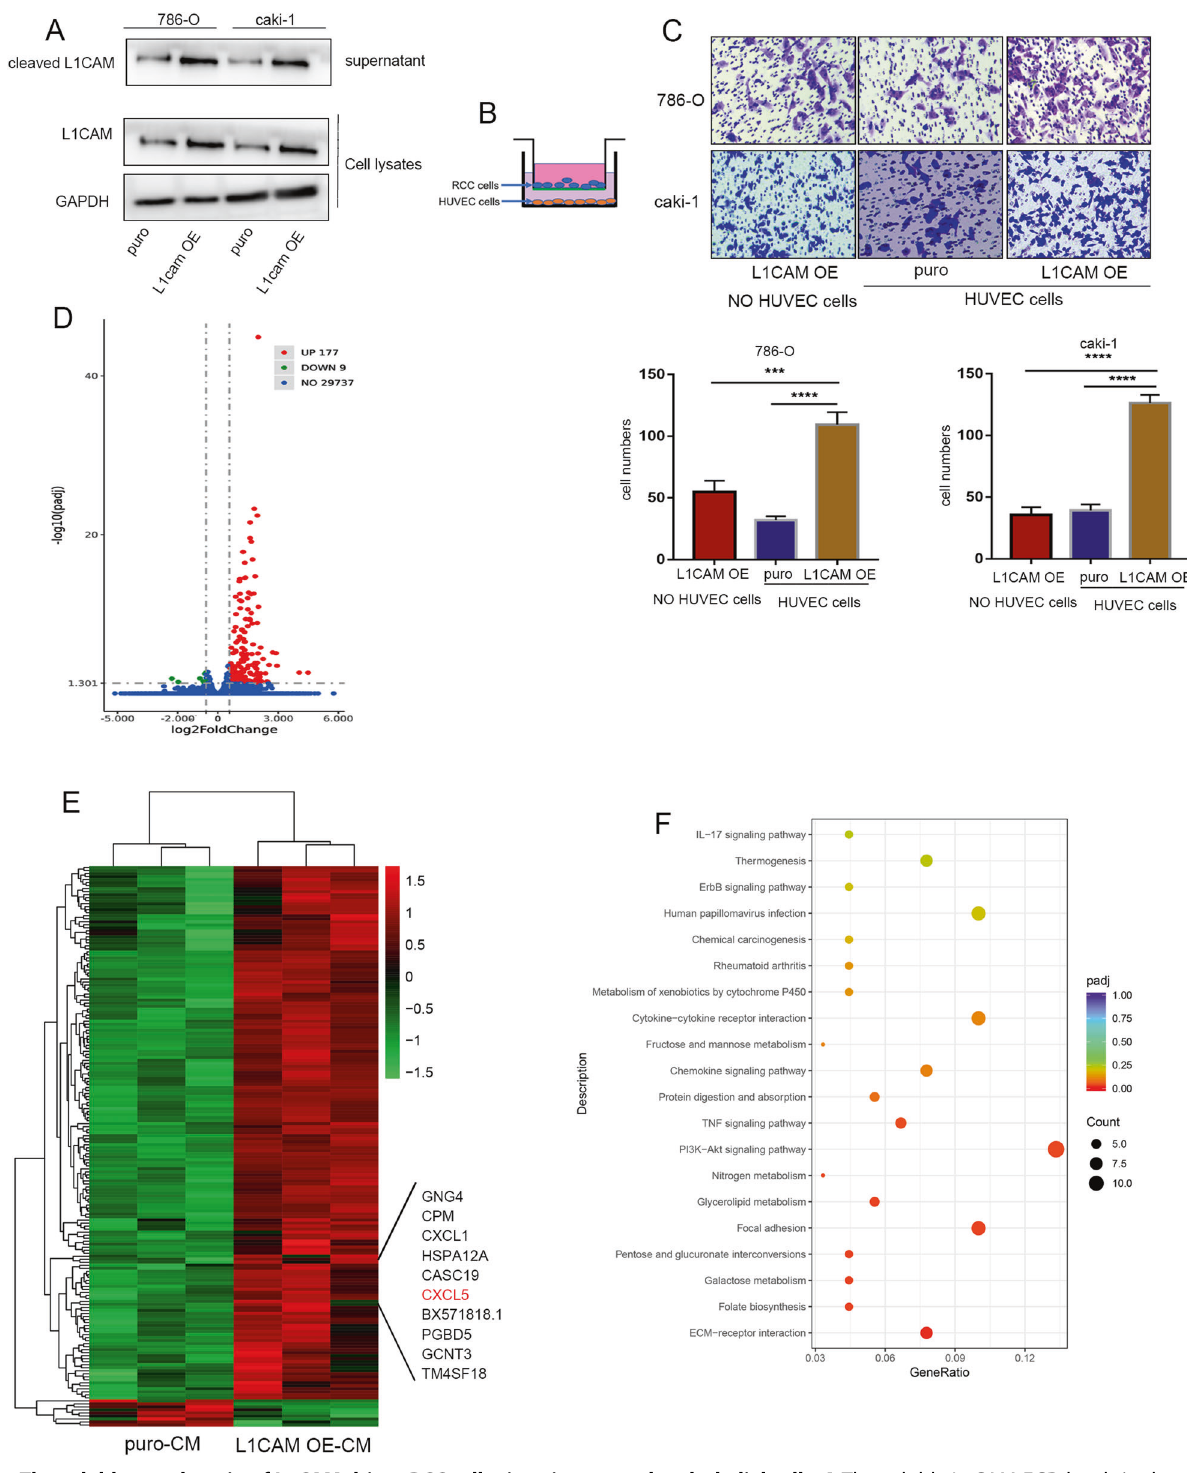
Fig. 4 The soluble ectodomain of L1CAM drives RCC cell migration toward endothelial cells. A The soluble L1CAM-ECD levels in the culture supernatant were detected by western blotting after ultra fi ltration using a 30-kDa ultra fi ltration tube. B , C Transwell co-culture system of RCC and HUVEC and chemotaxis assays. RCC cells were seeded into 24-well Transwell upper chambers, and HUVEC were seeded into 24-well plates. After 6 h of incubation at 37 °C, the non-migrating cells were removed, and the number of migrated cells was randomly selected under the microscope from fi ve fi elds of view. D , E Supernatants from L1CAM-overexpressing Caki-1 cells and control cells were collected after 48 h of culture. HUVECs were cultured in conditioned media for 24 h, followed by transcriptome analysis. Differentially expressed genes (DEGs) were identi fi ed and visualized using volcano plots and heat maps. F KEGG pathway analysis of the DEGs.